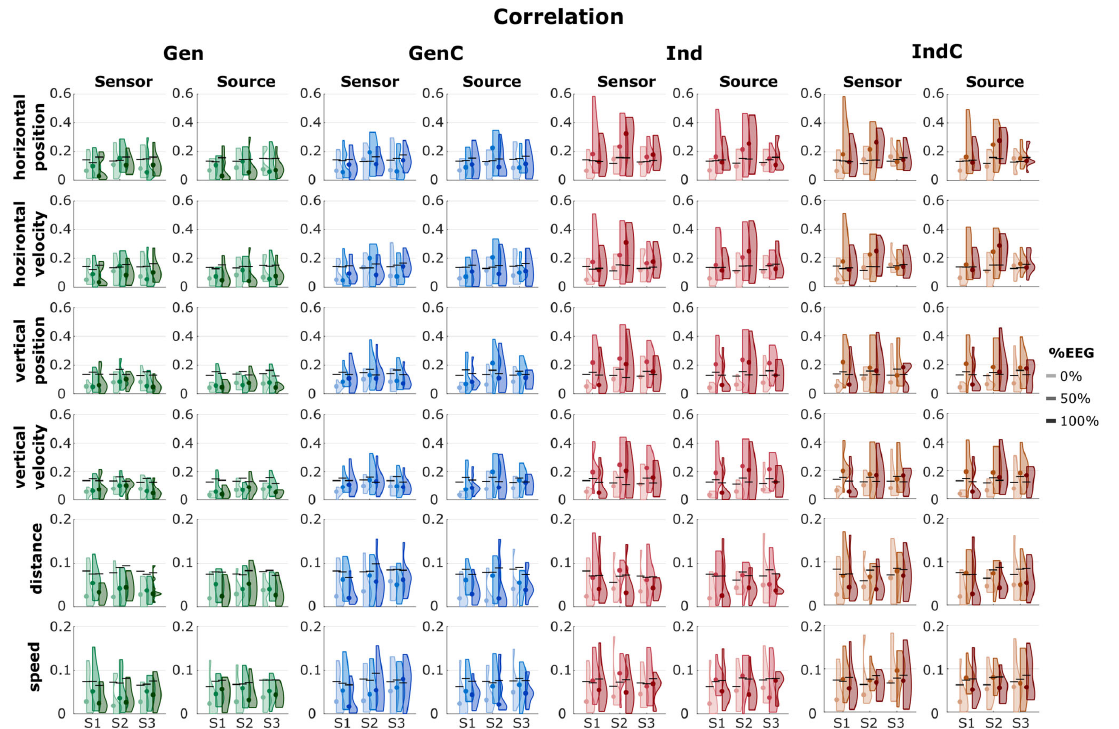
Figure 3. Plots of the distribution of correlations from 4 different scenarios: Gen, GenC, Ind, and IndC, indicated by different colors. The intensity of the color indicates the measurement block, either 0%, 50%, or 100% EEG from sessions 1, 2, and 3, indicated as S1, S2, and S3, respectively. The black horizontal line shows the chance level, while the dot represents the median value of the corresponding measurement block. The corresponding median correlations are summarized in Table S1.